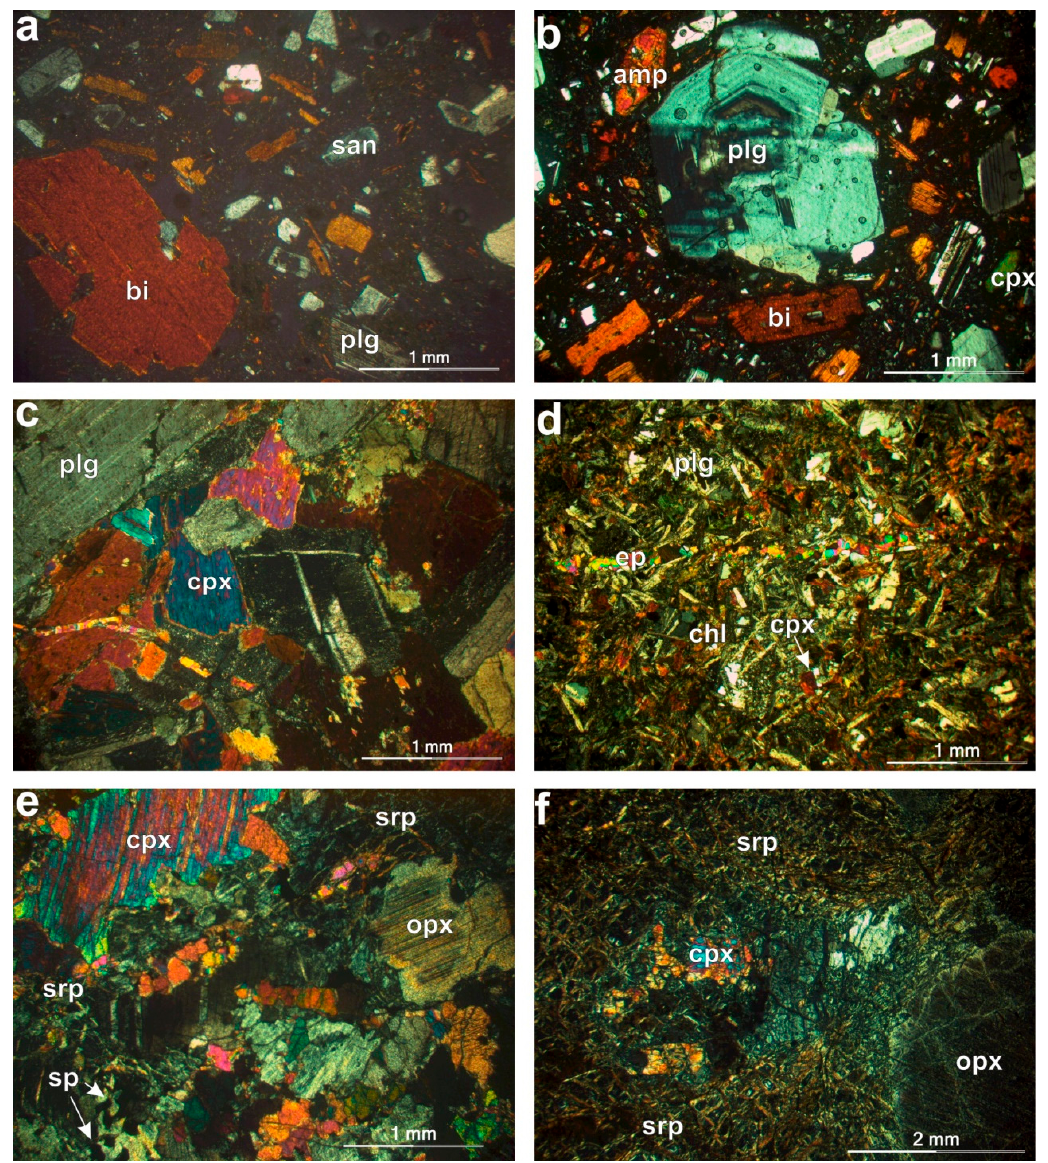
Figure 2. Photomicrographs of representative investigated rocks (XPL: cross polarized light) presenting: ( a ) Dacite showing porphyritic texture with phenocrysts of plagioclase, biotite and sanidine (sample S4), ( b ) porphyritic texture in andesite containing phenocrysts of plagioclase, biotite, amphibole and clinopyroxene (sample S6), ( c ) gabbro exhibiting granular texture (sample S15), ( d ) diabase exhibiting subophitic texture (sample S9), ( e ) cataclastic texture in a serpentinized lherzolite with lamellae extinction of clinopyroxene crystals (sample 31), ( f ) serpentinized lherzolite with few relics of clinopyroxene (sample 27). ep: epidote, san: sanidine; cpx: clinopyroxene, plg: plagioclase, opx: orthopyroxene; sp: spinel; amp: amphibole; chl: chlorite, srp: serpentine, bi: biotite.